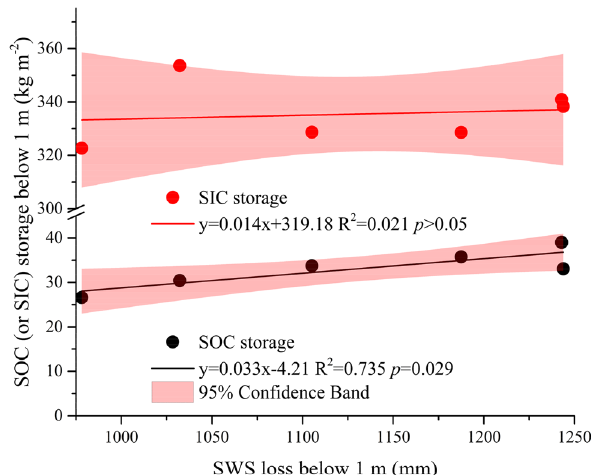
Figure 7. Relationship between SOC and SIC storage with SWS loss below 1 m down to 20